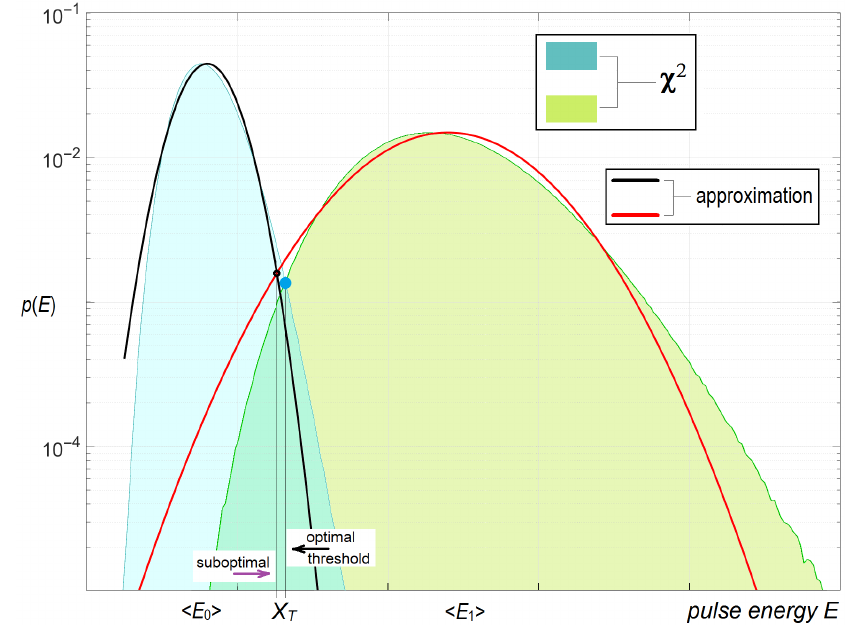
Figure 6. χ 2 -distributions and their approximations for E 0 and E 1